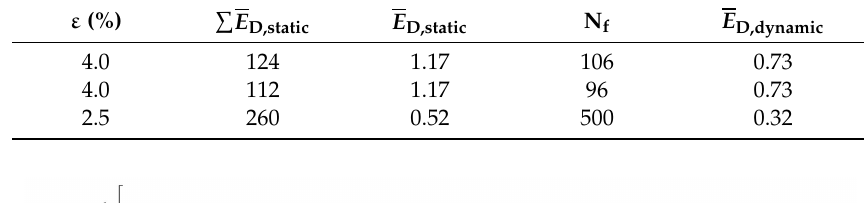
Table 2. Ultimate normalized energy dissipation capacity.